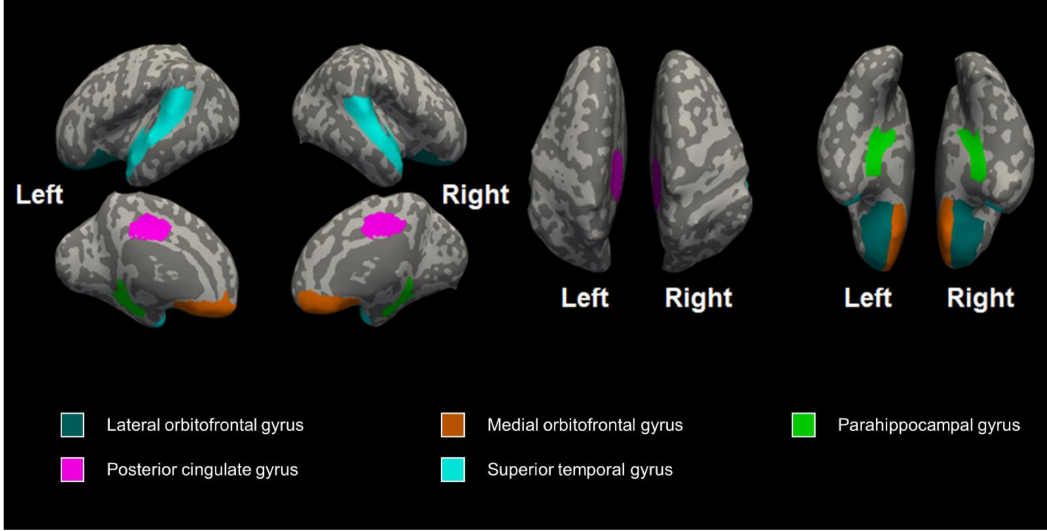
Figure 1. The regions of the brain curvature that we observed.